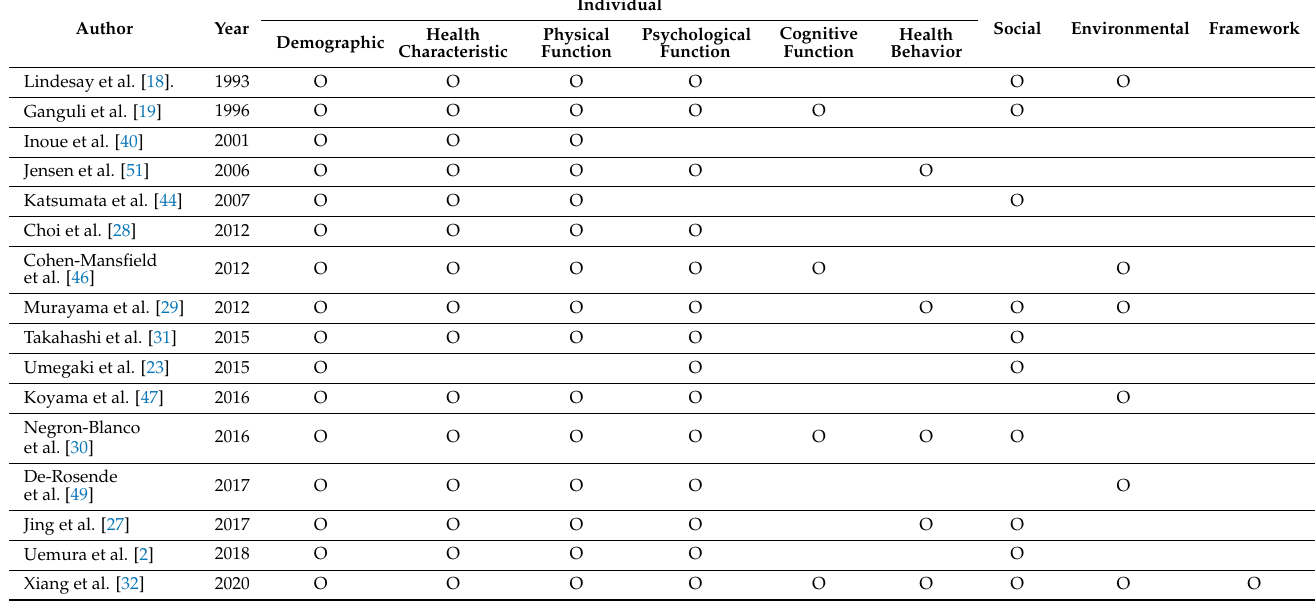
Table 4. Determinants of HB state based on individual, social, and environmental factors. Individual Social Environmental Framework Demographic Health Characteristic Physical Function Psychological Function Cognitive Function Health